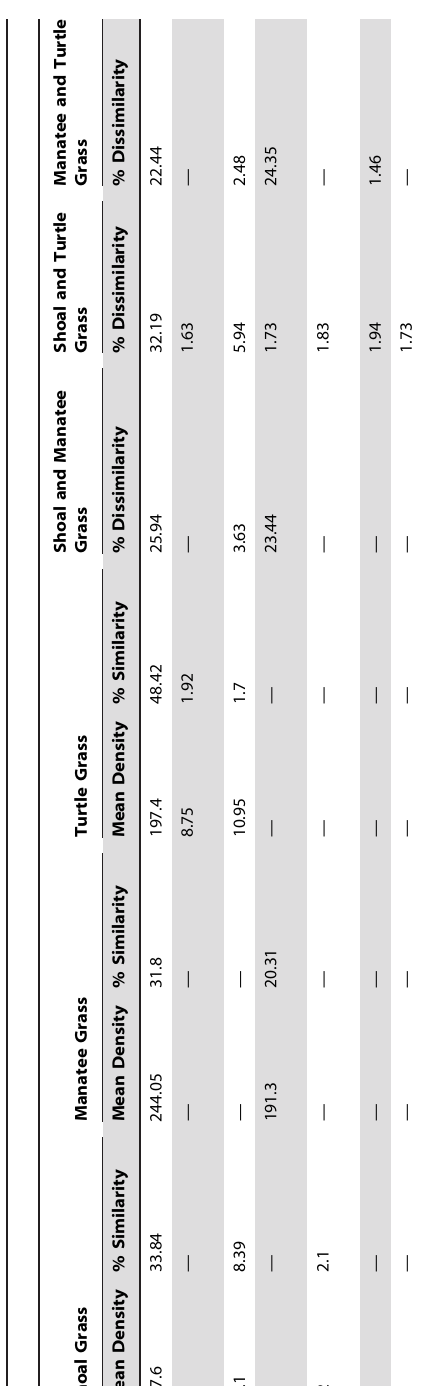
Figure 3. MDS ordination of fish, shrimp, and crabs among 3 seagrass species.